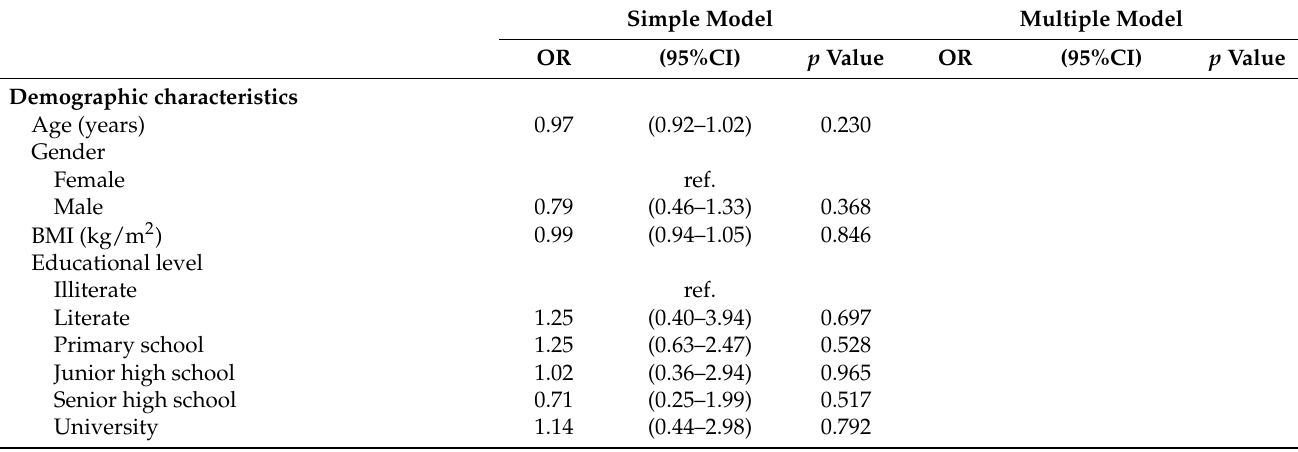
Table 5. Predictors of admission within three months after index emergency department